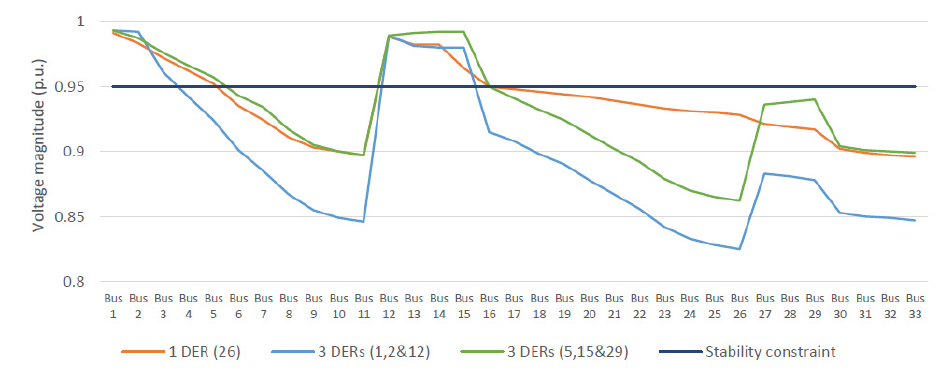
Figure 10. Comparison of voltage profile.